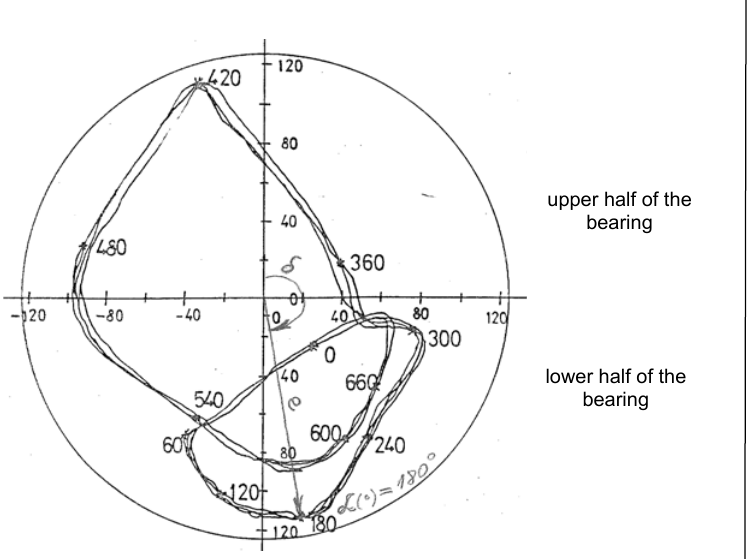
Figure 14 – Display of the measured dynamic sleeve trajectory on the 1st main bearing of the crankshaft, at the engine load of 100%, n = 720 min -1 , and the bearing clearance Z=124 ( 